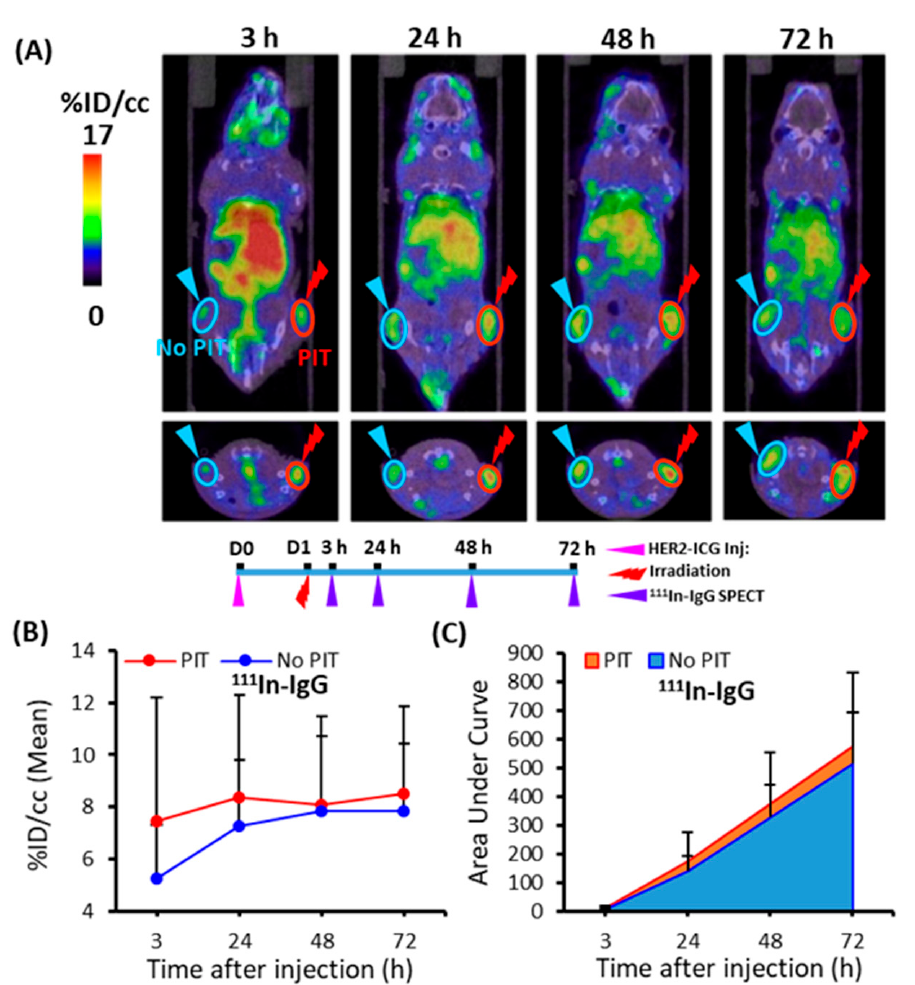
Figure 7. Temporal SPECT/CT imaging of 111 In-IgG in tumor-bearing mice. ( A ) Representative SPECT/CT images at 3, 24, 48, and 72 h after intravenous injection of 111 In-IgG are shown. The right tumor was irradiated with NIR light at 40 min before SPECT. ( B ) Time-activity curve of average accumulation of 111 In-IgG. ( C ) Summed values of the areas under the curve (AUCs) for each time point were evaluated. These data showed a tendency for increased accumulation of 111 In-IgG in PIT-treated tumors (red), although more sample numbers are required for the statistically significant difference. Data are presented as means ± SD ( n = 8).